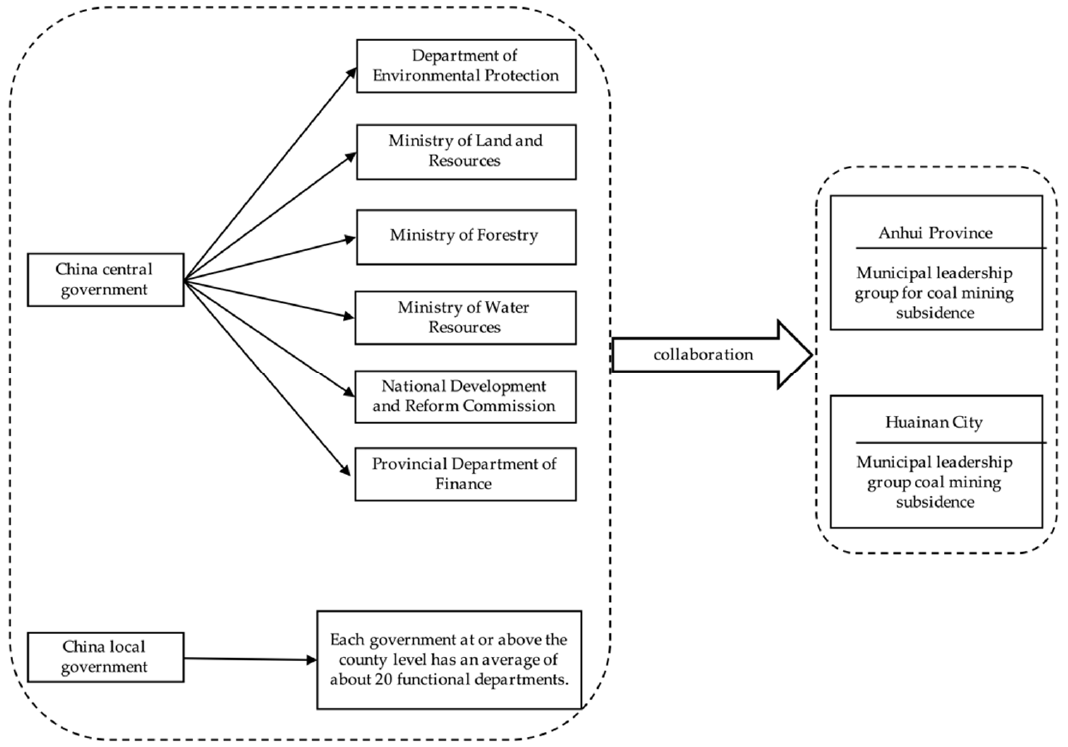
Figure 4. A network of government actors in ecological restoration of subsidence area. Source: Organized by the authors.